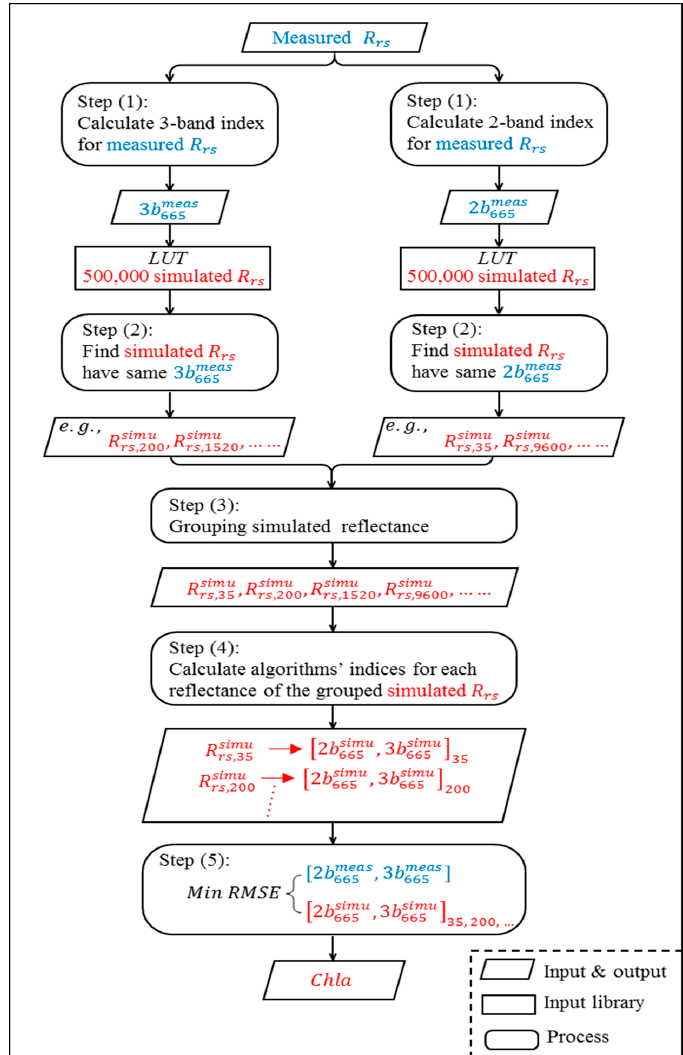
Figure 5. Concept and schematic flowchart of the multi-algorithm indices and the look-up table (MAIN-LUT) technique for the 2-indices-[665] combination. For other combinations in Table 4, a similar concept was employed. 2 b 665 stands for 2b [665, 709] algorithm’s index (= R rs ( 709 ) / R rs ( 665 )) ; 3 b 665 refers to the 3b [665, 709, 754] algorithm’s index (= [ 1/ R rs ( 665 ) − 1/ R rs ( 665 )] ∗ R rs ( 754 )) ; LUT represents the look-up table; numbers like 35 in R simu rs ,35 represents the tagged number for each simulated R rs that range from 1 to 500,000; and meas and simu denote measured and simulated, respectively. The blue and red colors highlight the measured and simulated parameters, respectively.